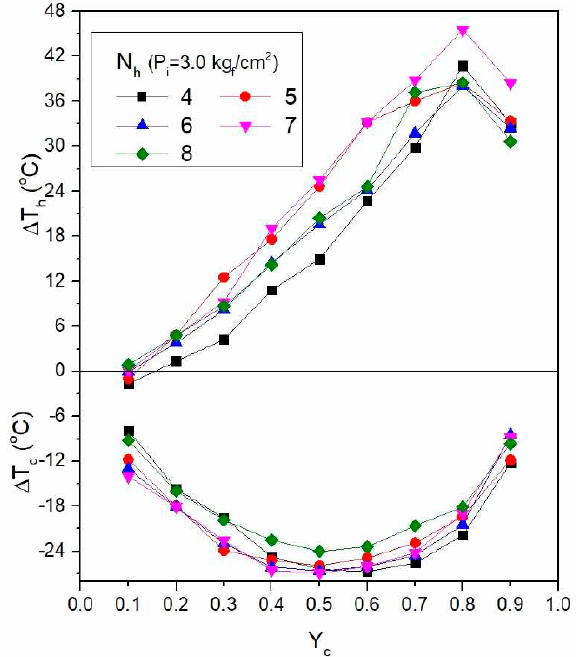
Figure 16. Temperature differences ∆ T h and ∆ T c according to inlet pressure (P i ) 3.0 kgf/cm 2 .